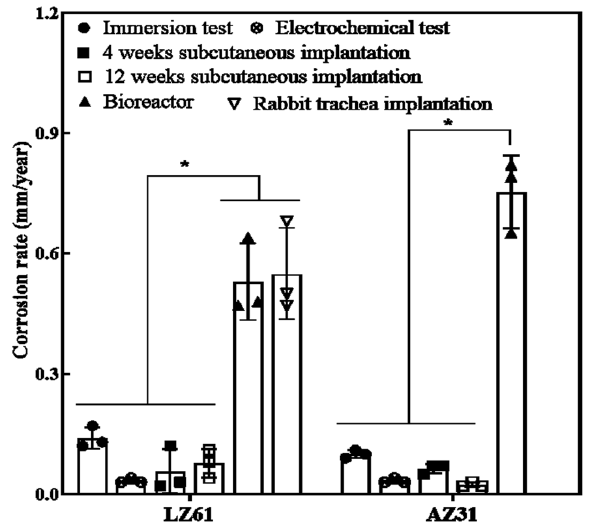
Fig. 7 A summary of corrosion rate of LZ61-KBMS and AZ31 alloy under different tests. Immersion test: 5-week corrosion rates calculated based on the immersion test; Electrochemical test: corrosion rates calculated based on Tafel plot; 4-weeks subcutaneous implantation: corrosion rates calculated based on the weight loss after 4 weeks of implantation; 12-weeks subcutaneous implantation: corrosion rates calculated based on the weight loss after 12 weeks of implantation; Bioreactor: corrosion rate calculated based on the stent volume loss after 5 weeks of immersion in bioreactor; Rabbit trachea implantation: corrosion rate calculated based on the stent volume loss after 4-weeks implantation in rabbit trachea. *denotes a signi fi cant difference between alloy groups ( p < 0.05, n = 3). Corrosion rates calculated from bioreactor and rabbit trachea implantation are from the current study, the rest are derived from our previous published study 31